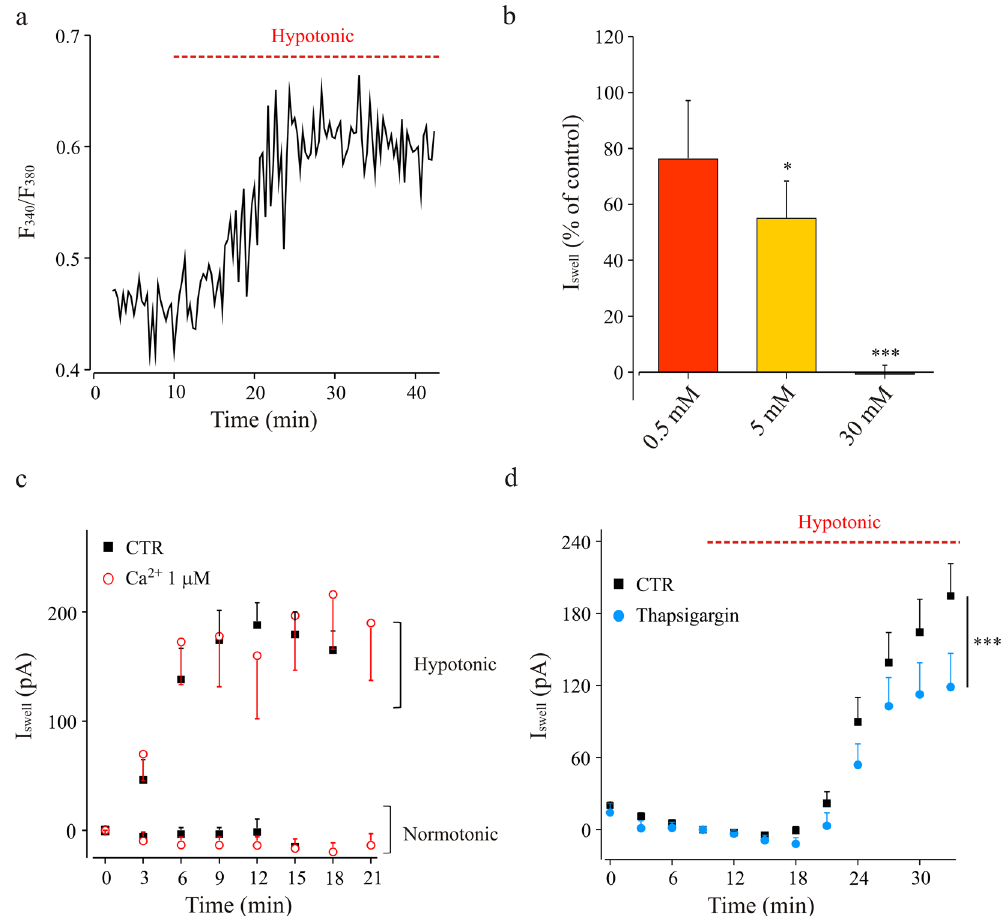
Figure 7. Intracellular Ca 2 + increase is necessary for the hypotonic-induced current activation. ( a ) Representative trace of intracellular Ca 2 + increase in a Fura-2-loaded (100 μ M) microglia cell, recorded in hippocampal slices under acute hypotonic stimulation (red bar, 8–10% dilution). ( b ) Bar chart of I Swell amplitude measured in presence of BAPTA 0.5, 5 and 30 mM in the pipette solution, expressed in percentage (see 6c). Internal controls were recorded in the same experimental days with EGTA 0.5 mM in the pipette solution. BAPTA 0.5 mM: red; n = 9 vs n = 9; p = 0.4, t-test. BAPTA 5 mM: yellow; n = 14 vs n = 25; p < 0.05, t-test. BAPTA 30 mM: green; n = 6 vs n = 8; p < 0.001, t-test. I swell amplitude as in 5c. Statistics as in 6c. (c) Time- course of I Swell amplitude recorded in control conditions (black squares, CTR) and with 1 μ M free [Ca 2 + ] i , (red circles) in the pipette solution, under normotonic or hypotonic extracellular stimulation, as indicated. Notice that, high [Ca 2 + ] i was unable to activate I Swell (red circles, n = 6; p = 0.3 vs CTR, black squares, n = 8) in the absence of hypotonic stimulation, or to modulate it under hypotonic stimulation (red circles, n = 5; p = 0.5 vs control, black squares, n = 11). ( d ) Time course of I Swell recorded with control pipette solution (n = 9; black) or containing thapsigargin (1 μ M; n = 13; blue). *** p = 0.001, two-way ANOVA,